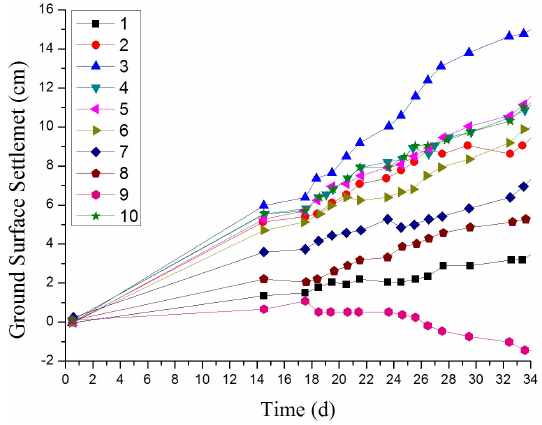
Figure 18. Settlement–time curve of the ground surface supported by the bench method.